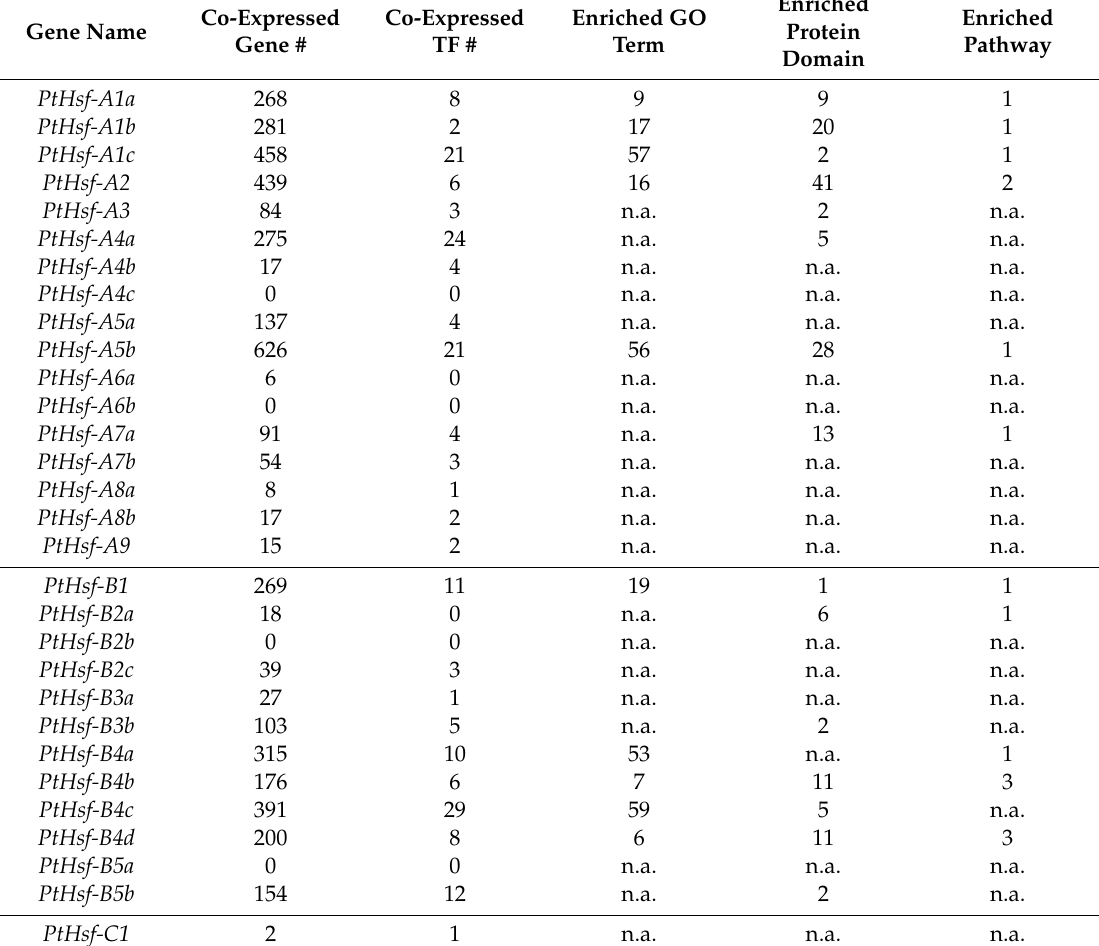
Table 1. The co-expressed genes and enrichment